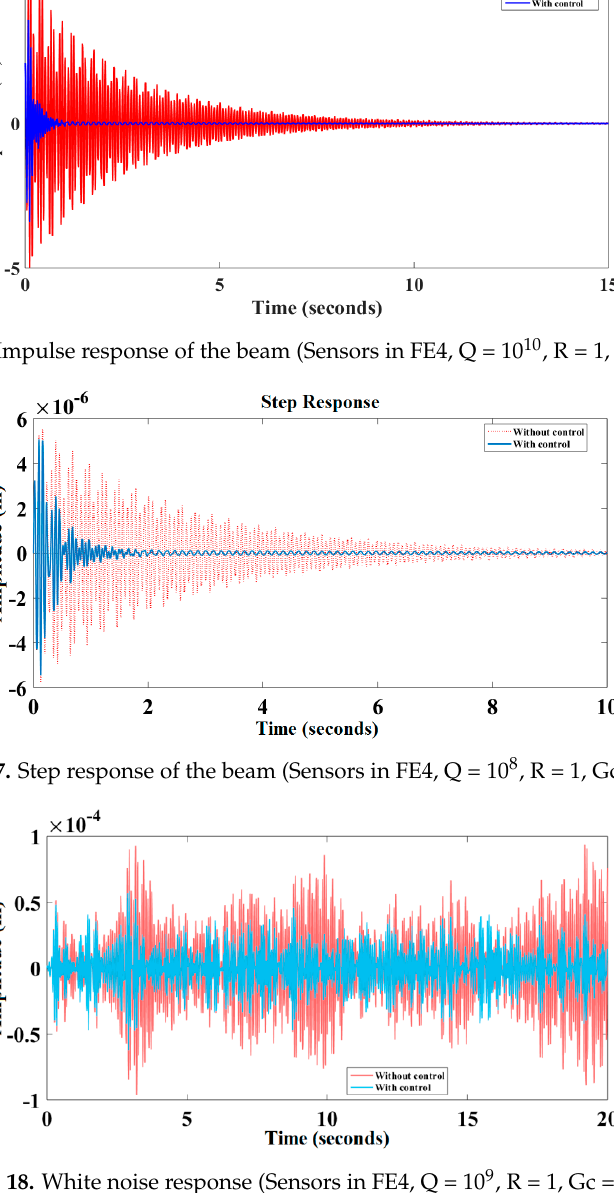
Figure 18. White noise response (Sensors in FE4, Q = 10 9 , R = 1, Gc = 100).